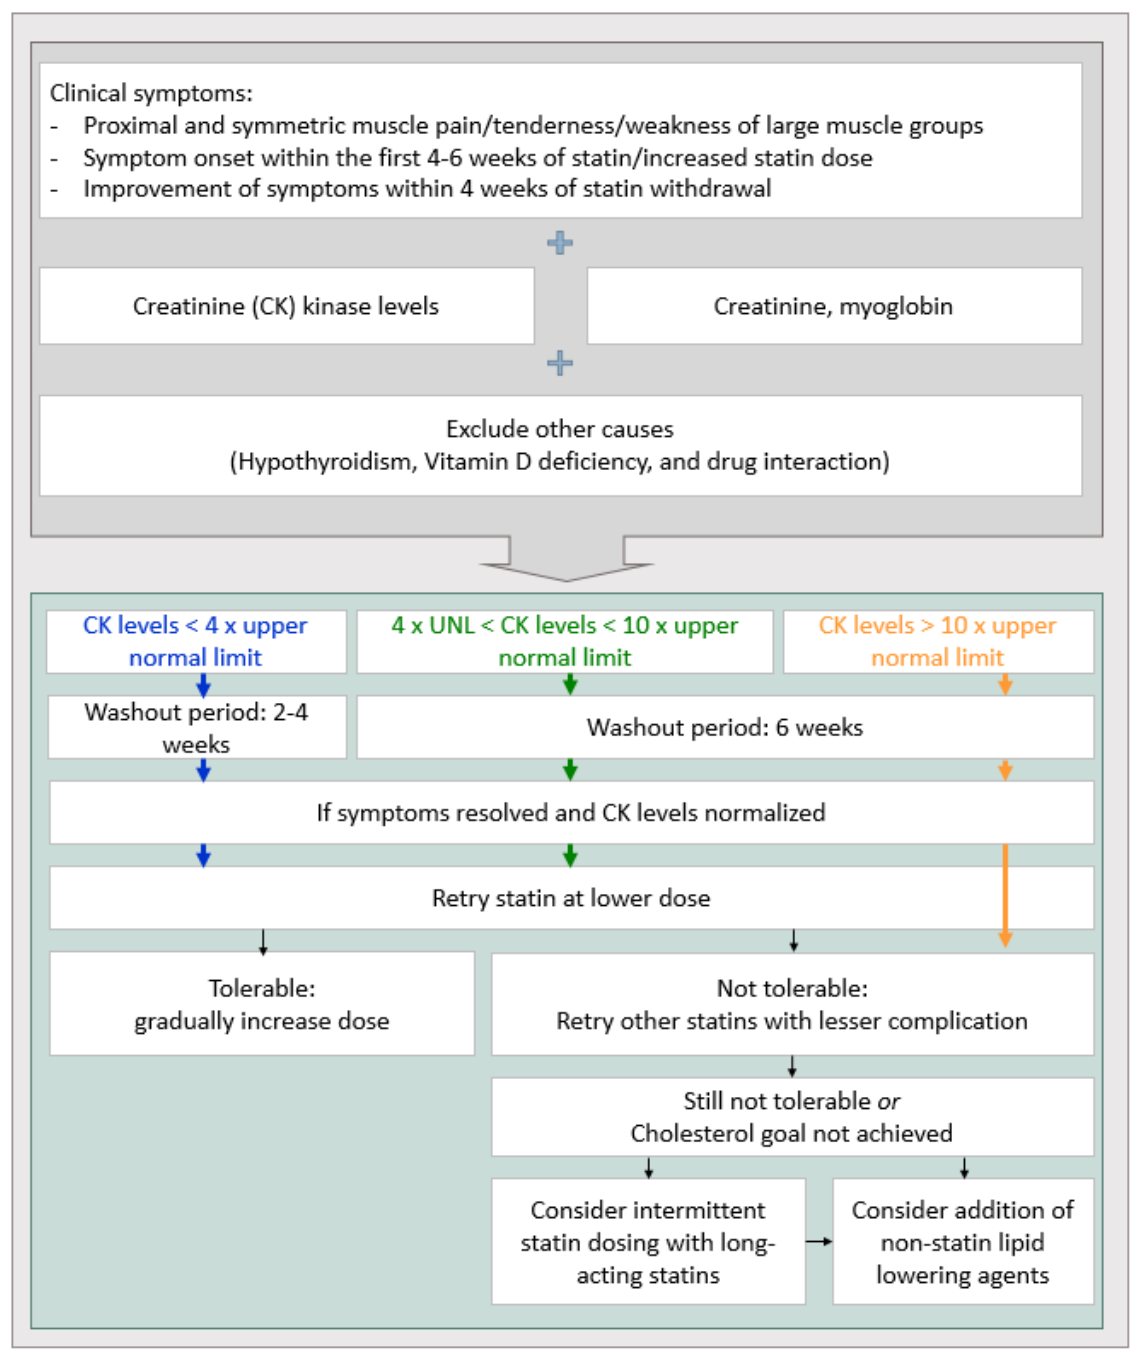
Figure 3. The strategy of statin treatment for muscle toxicity [56].